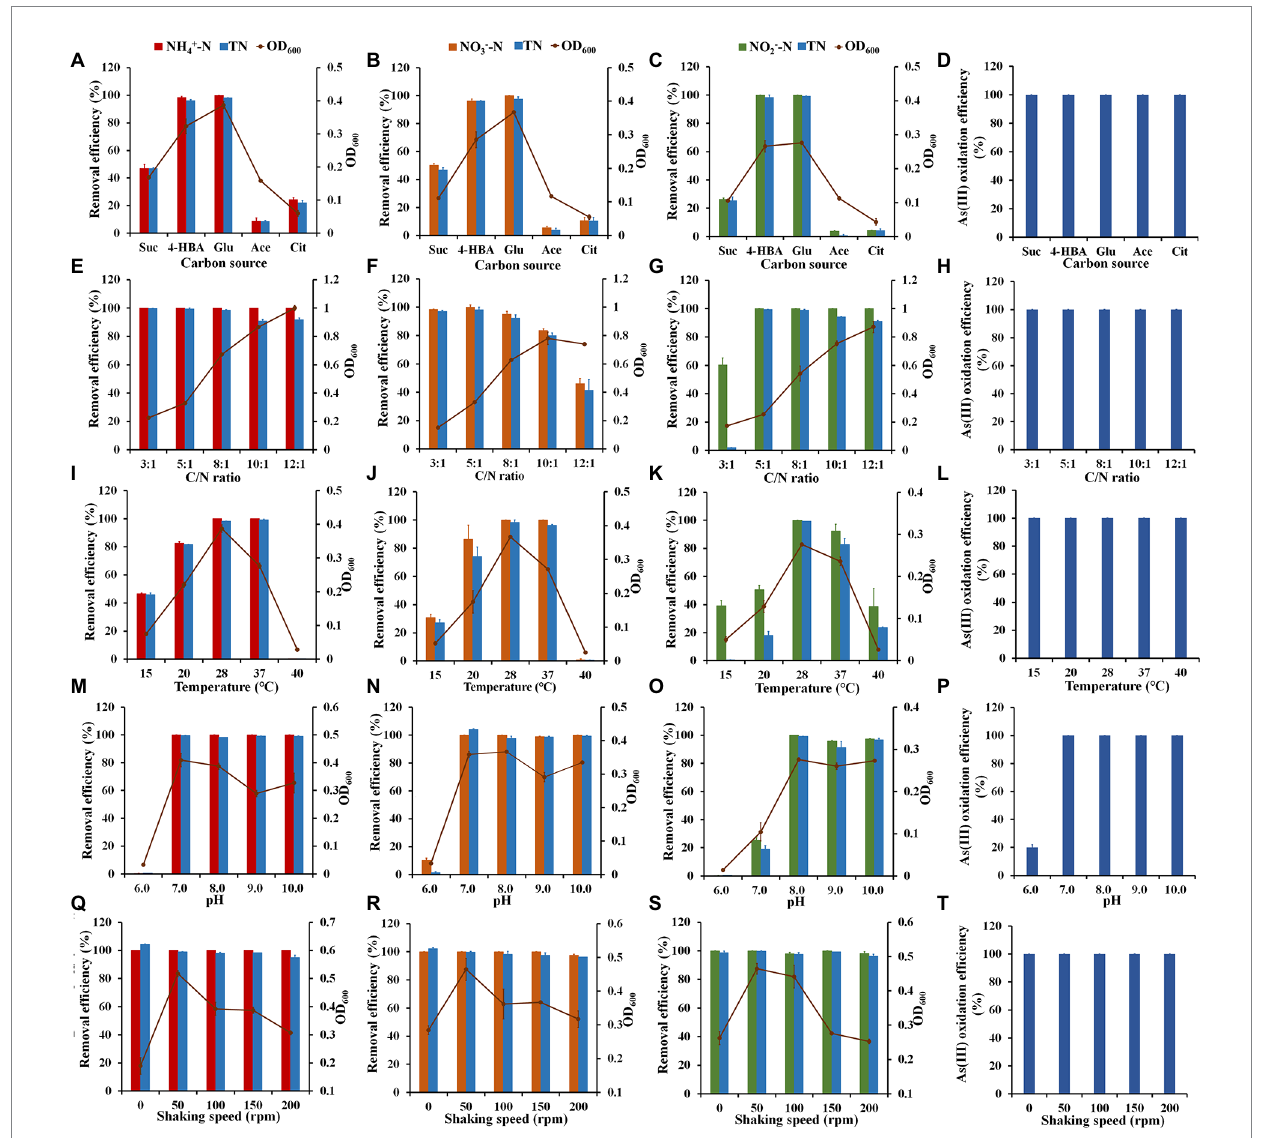
FIGURE 3 The effects of different factors on nitrification, denitrification, and As(III) oxidation of strain H7. (A–D) The effect of the carbon source on nitrogen removal and As(III) oxidation. (E–H) The effect of C/N on nitrogen removal and As(III) oxidation. (I–L) The effect of temperature on nitrogen removal and As(III) oxidation. (M–P) The effect of pH on nitrogen removal and As(III) oxidation. (Q–T) The effect of shaking speed on nitrogen removal and As(III) oxidation. A, D, E, H, I, L, M, P, Q, and T used NH 4+ -N as the sole nitrogen source. B, F, J, N, and R used NO 3 − -N as a sole nitrogen source. C, G, K, O, and S used NO 2 − -N as the sole nitrogen source. Suc, sodium succinate; 4-HBA, 4-hydroxybenzoate; Glu, glucose; Ace, sodium acetate; Cit, sodium citrate. Error bars represent the mean ± standard deviation ( n = 3). Some lines had no error line as a result of the value was